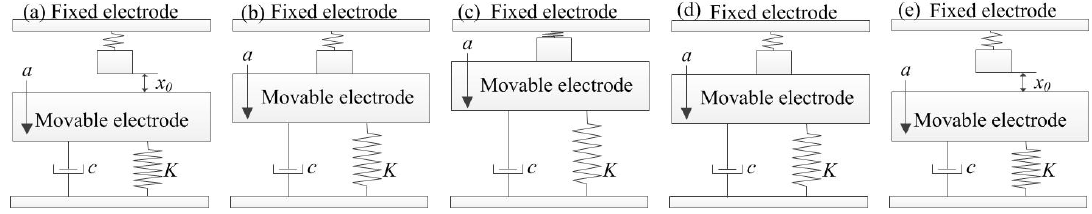
Figure 6. The vibrational transfer process and corresponding on-off state.